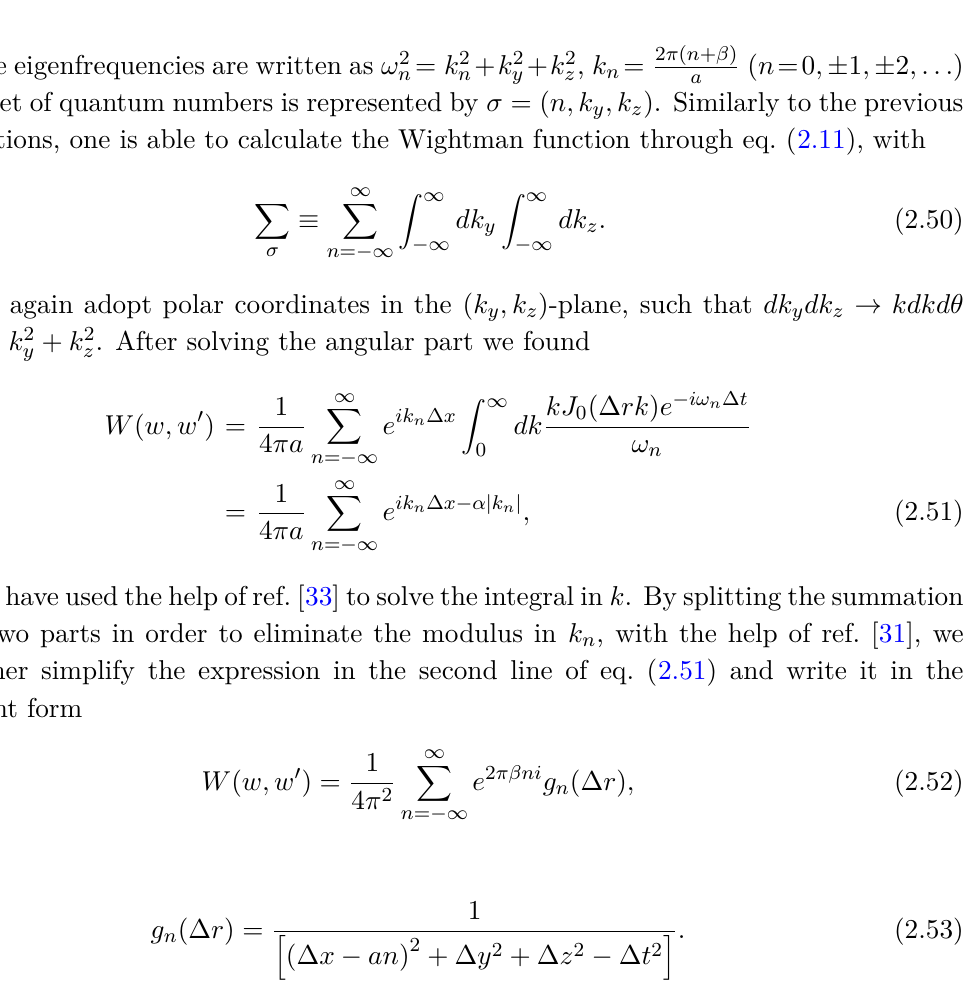
Figure 2 . Illustrative representation of four-dimensional spacetime with a compactified spatial dimension. The spacetime is composed of a compactified spatial dimension x , S 1 , and the tridi- mensional space R 3 of coordinates t, y, z